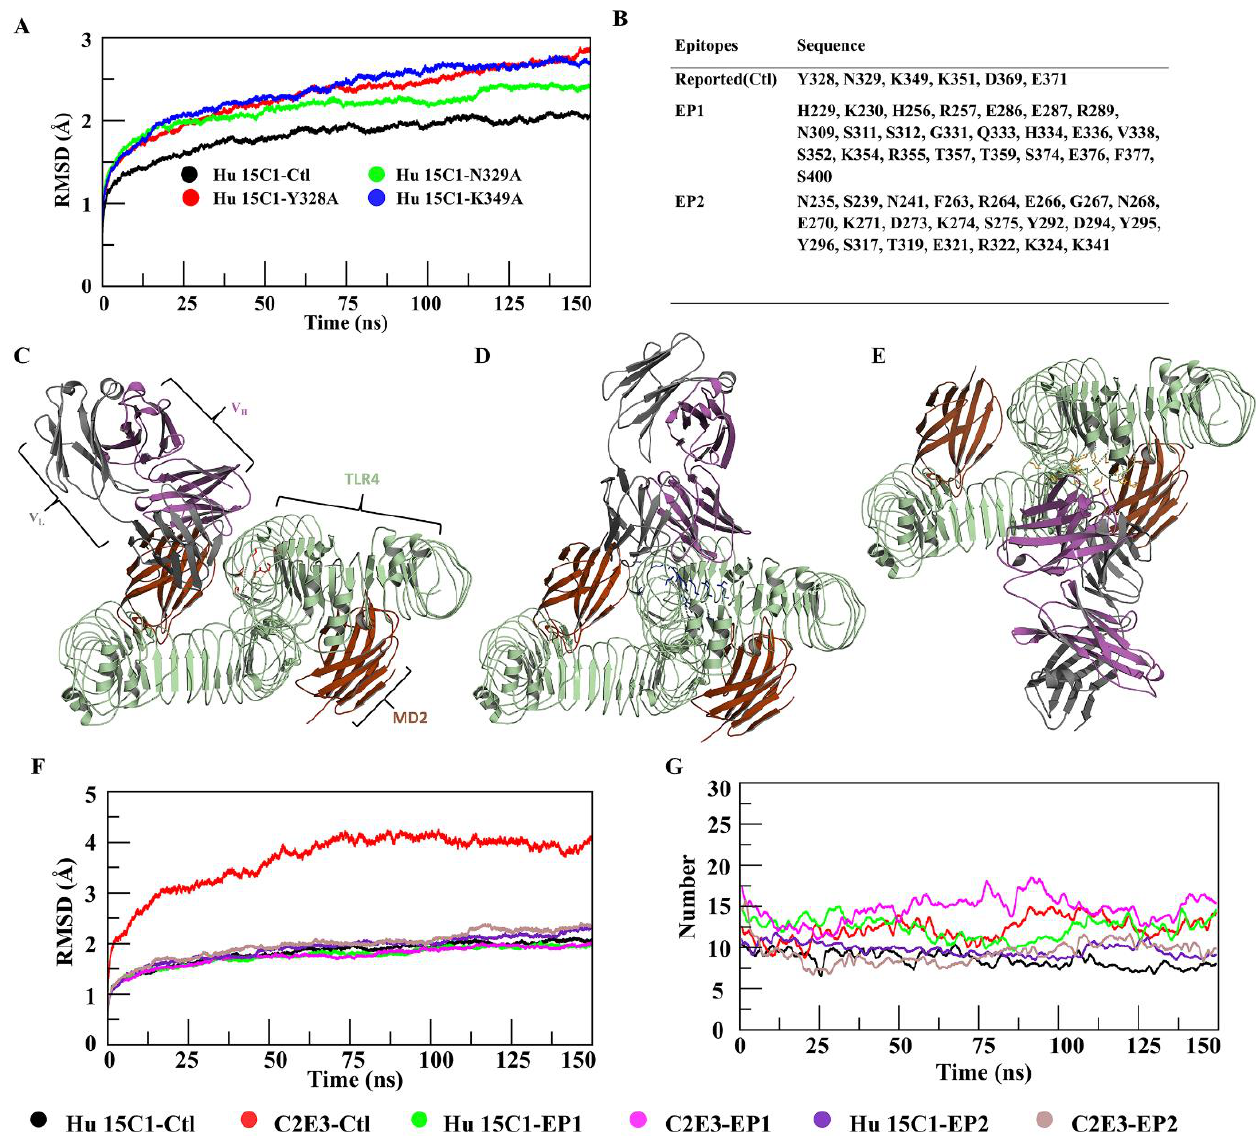
Figure 3. Epitope prediction and docking mode and stability analysis. ( A ) RMSDs of four complexes in which mutated complexes showed an increasing trend. ( B ) Residues for the construction of three conformational epitopes. Modes of docking of Hu 15C1 with TLR4 at sites ( C ) Ctl, ( D ) EP1, and ( E ) EP2 with superimposition of the human TLR4 – MD2 dimer. RMSDs of six complexes are illustrated in ( F ), where C2E3 – Ctl (red) showed a maximum deviation, and all remaining complexes were stable. The number of hydrogen bonds during the simulation was determined in ( G ), where C2E3 – EP1 (magenta) featured the highest, C2E3 – Ctl (red) and Hu 15C1 – EP1 (green) moderate, and Hu 15C1 – Ctl (black), Hu 15C1 – EP2 (blue), and C2E3 – EP2 (brown) the lowest number of hydrogen bonds formed during the simulation .